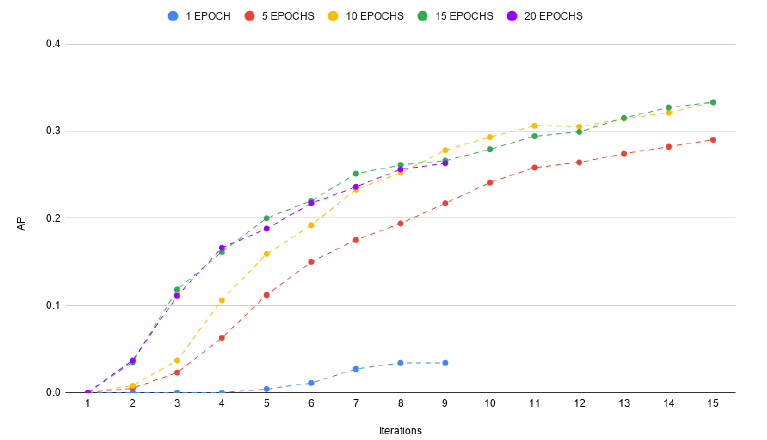
Figure 2. AP to the number of iterations for network trained with batch size of 10.